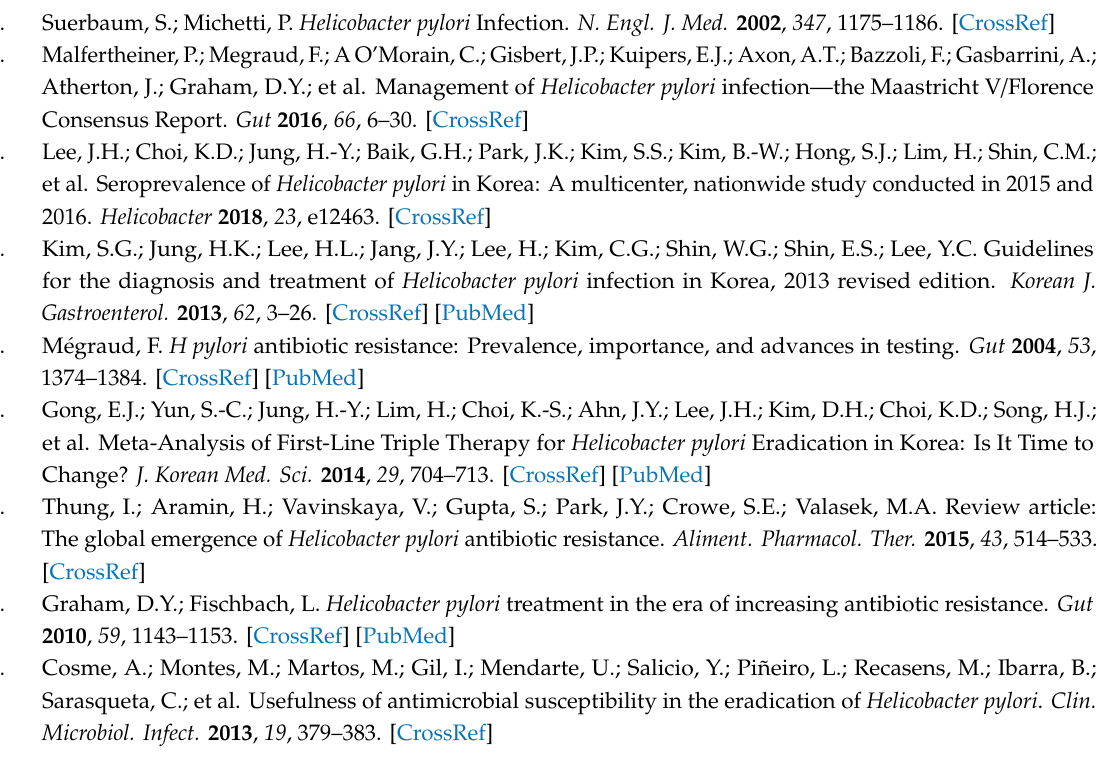
Figure S1: Visually depicted location of mutations in 23S rRNA genes of 46 H. pylori strains. A total of 42 mutations were detected on 40 nonidentical loci; Figure S2. Mutations in 23S rRNA genes at each nucleotide position and distribution of minimum inhibitory concentrations (MIC) for clarithromycin before and after unsuccessful clarithromycin-containing triple therapy. Of note, 2147A > G mutation is found only in clarithromycin-resistant phenotype, with median MIC of 16 µ g / mL (range, from 4 to 32 µ g / mL). The 2186T > C mutation is detected in both clarithromycin-susceptible and resistant phenotypes. MIC, minimum inhibitory concentration; Table S1: Frequency of mutations in the 23S rRNA genes of 46 H. pylori strains according to the phenotypic resistance against clarithromycin before and after unsuccessful eradication therapy; Table S2. Assessment of linkage disequilibrium between mutations 2147A > G and 2186T > C in 23S rRNA